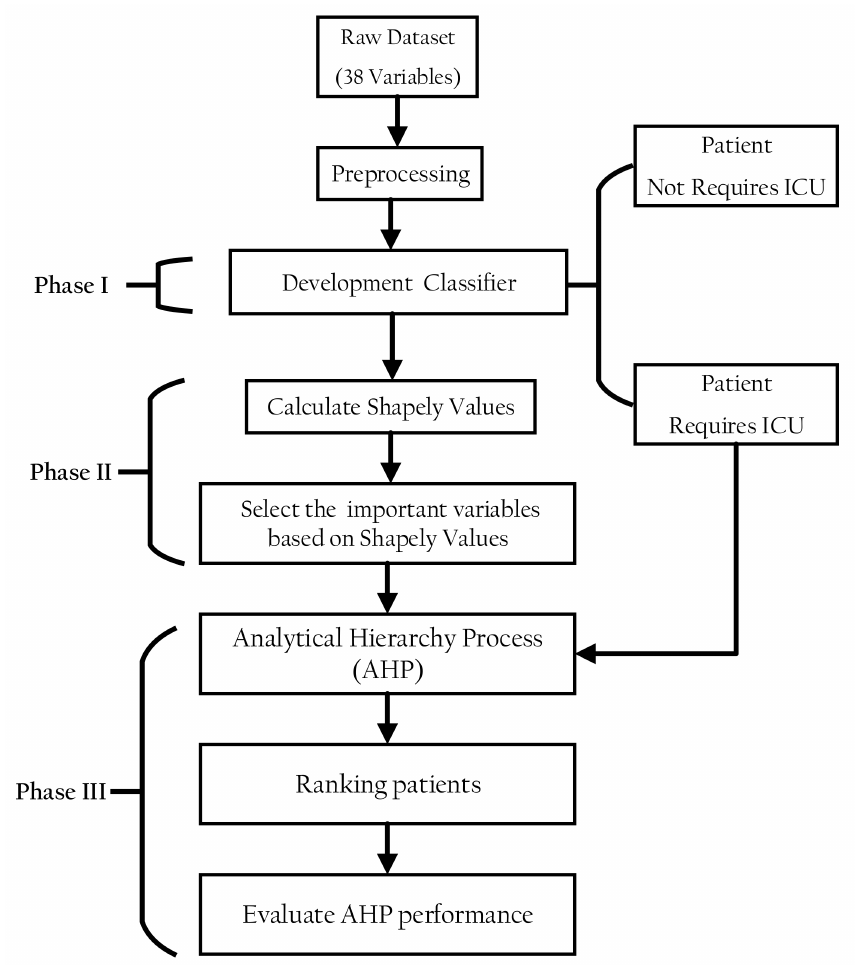
Figure 1. Structure of the research methodology phases.